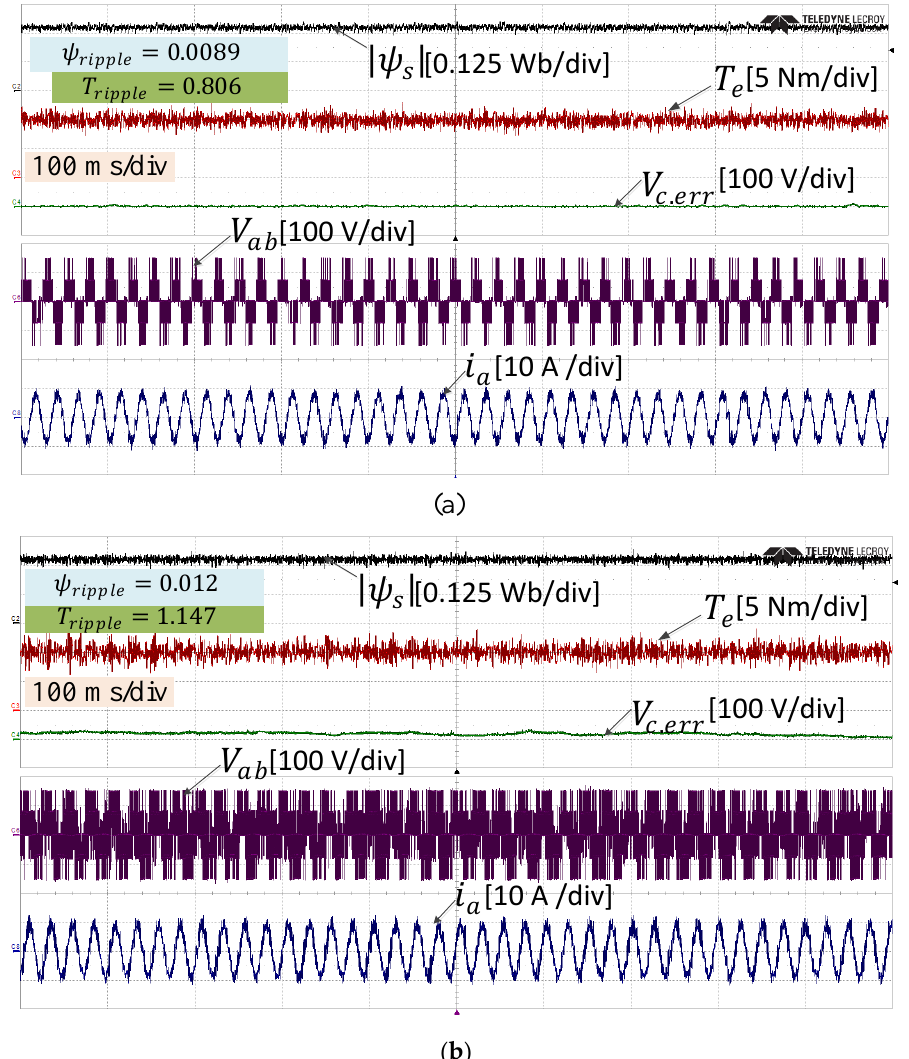
Figure 8. Experimental steady-state response at 600 rpm for ( a ) UFCS-PTC and ( b )